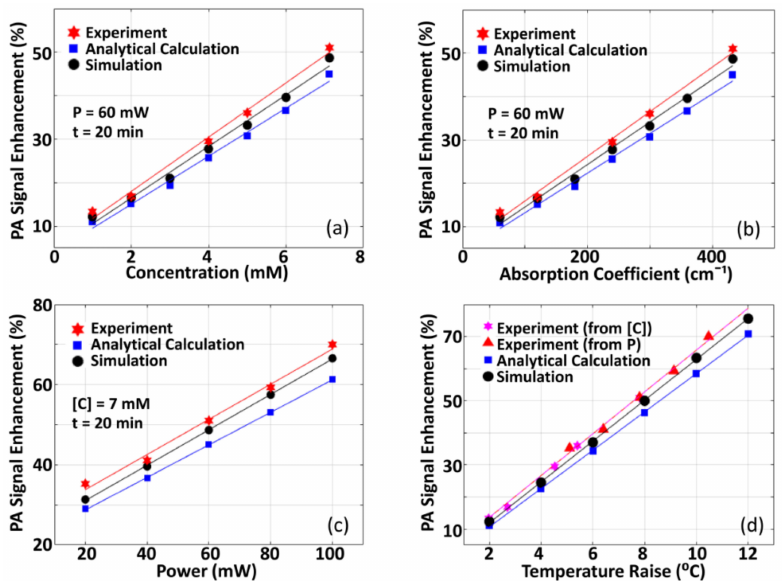
Figure 7. Comparison of the results obtained from experiments, theoretical hypothesis, and numerical ( enh ) simulation. ( a ) Variation of P with concentration (we employed P = 60 mW and t = 20 min), 0 ( enh ) ( b ) Variation of P with optical absorption coefficient ( P = 60 mW and t = 20 min were employed). 0 ( enh ) ( c ) Variation of P with optical power ( where [ C ] = 7mM and t = 20 min). ( d ) Experimental 0 ( enh ) measurements in P with respect to temperature raise ( ∆ T ), with ∆ T being obtained from variation 0 of optical power as well as concentration. The wavelength of the pulsed laser used for experiment is 670